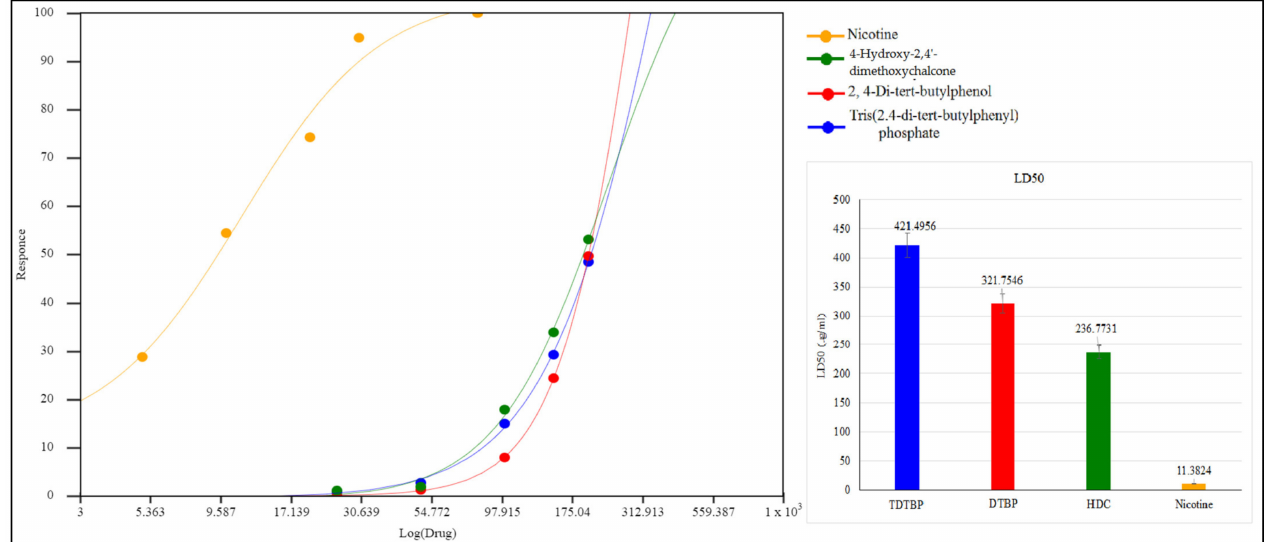
Figure 12. LD50 µ g/mL of test compounds TDTBP: Tris (2,4-di- tert -butylphenyl), HDC: (4-Hydroxy- 2,4 (cid:48) -dimethoxychalcone), and DTBP 3 (2,4-di- tert -butylphenol) and the standard